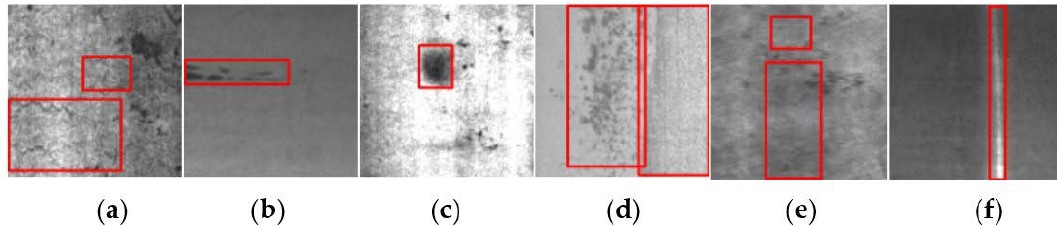
Figure 5. Examples of the NEU defect dataset. Each column represents a type of defect, and the defect areas are labeled by the red bounding boxes. ( a ) crazing; ( b ) inclusion; ( c ) patches; ( d ) pitted-surface; ( e ) rolled-in-scale; ( f ) scratches.